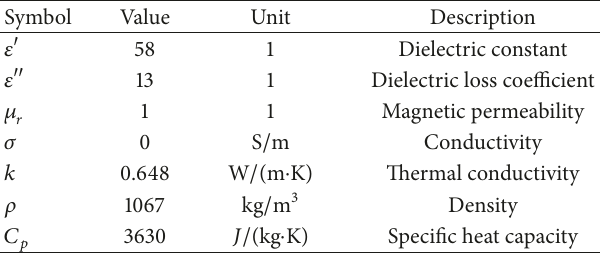
Table 1: Physical parameters of potato samples.